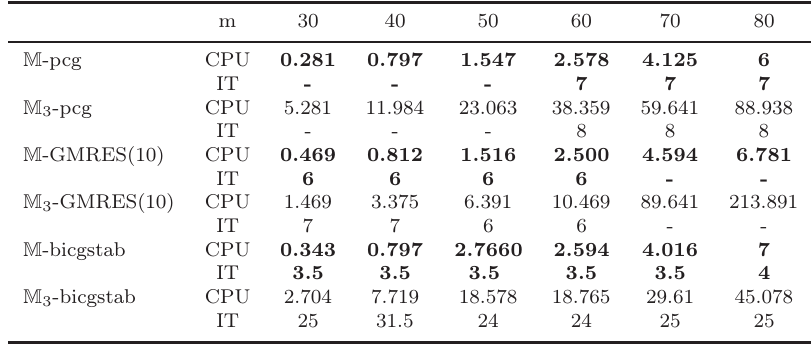
Table 3. Solution time in seconds and number of iterations of PCG, GMRES and BiCGSTAB iteration methods with preconditioners M presented in this paper and M 3 proposed in